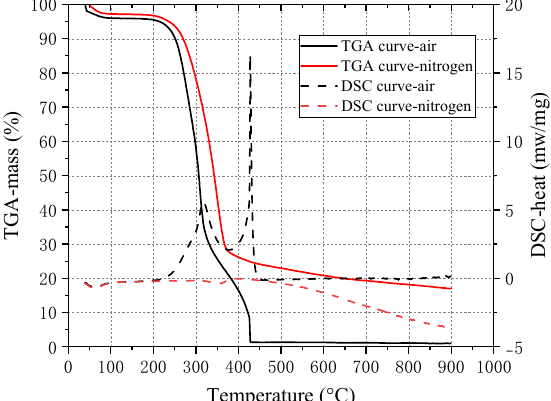
Figure 3. TGA-DSC test results of the Paulownia wood subjected to air and nitrogen atmospheres.